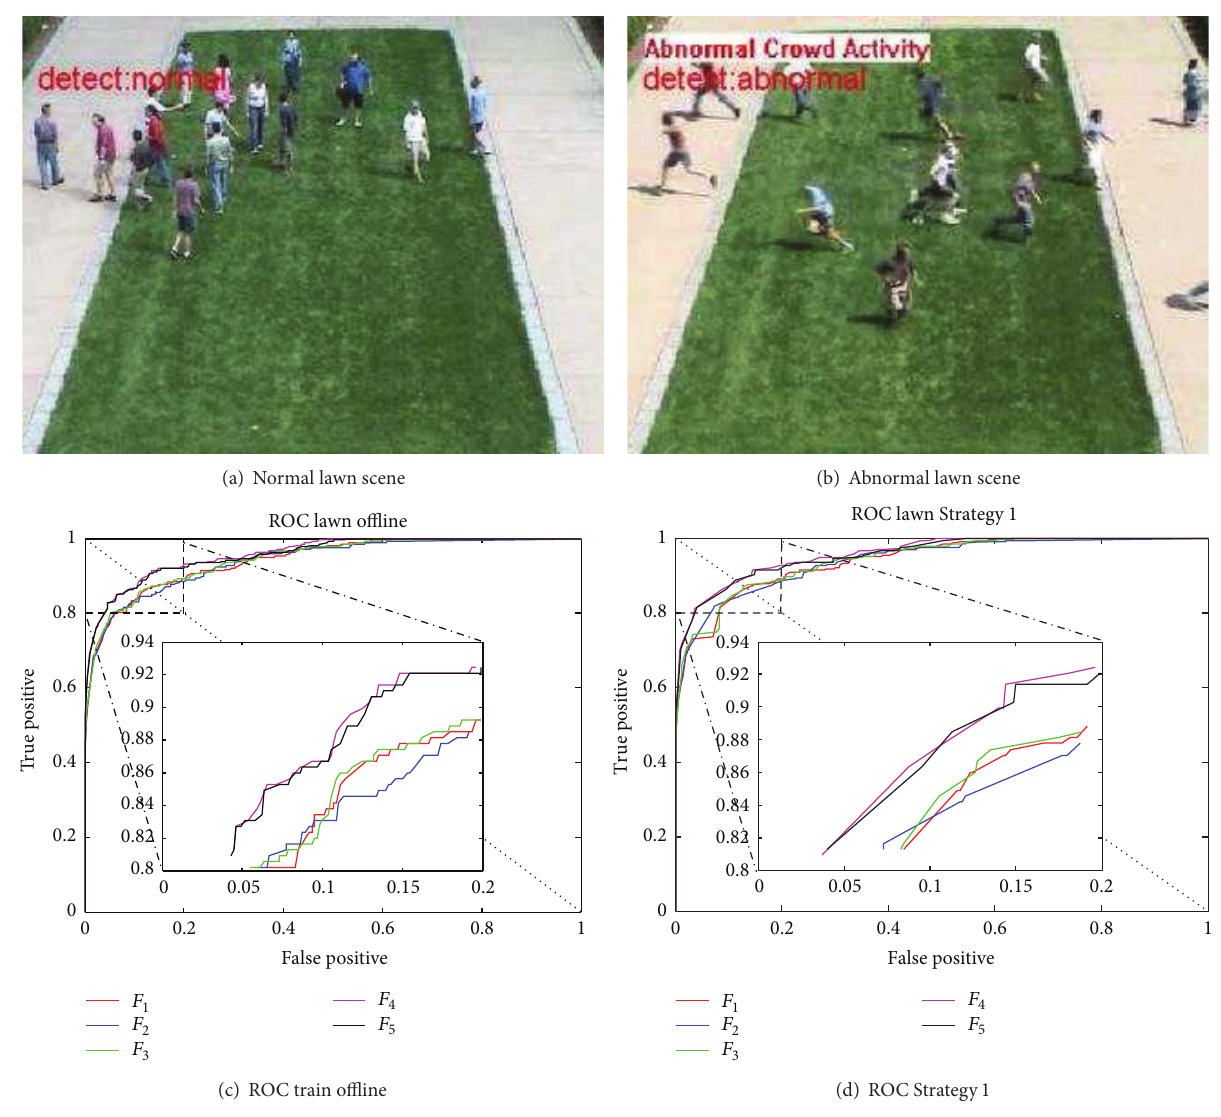
Figure 5: Detection results of the lawn scene. (a) The detection result of one normal frame. (b) The detection result of one abnormal panic frame. (c) ROC curve of different features 𝐹 of the lawn scene results via one-class SVM. All the training samples are learned together offline. The biggest AUC value is 0.9591. (d) ROC curve of different features 𝐹 results via Strategy 1 online one-class SVM. The biggest AUC value is